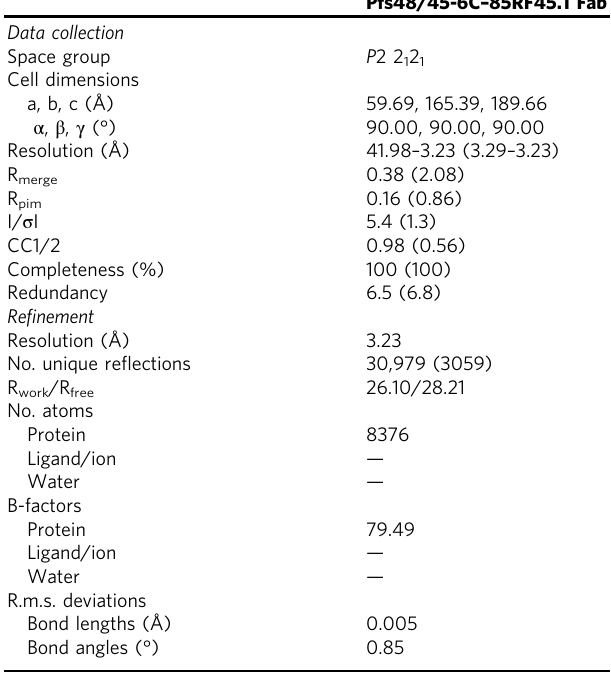
Table 1 Data collection and re fi nement